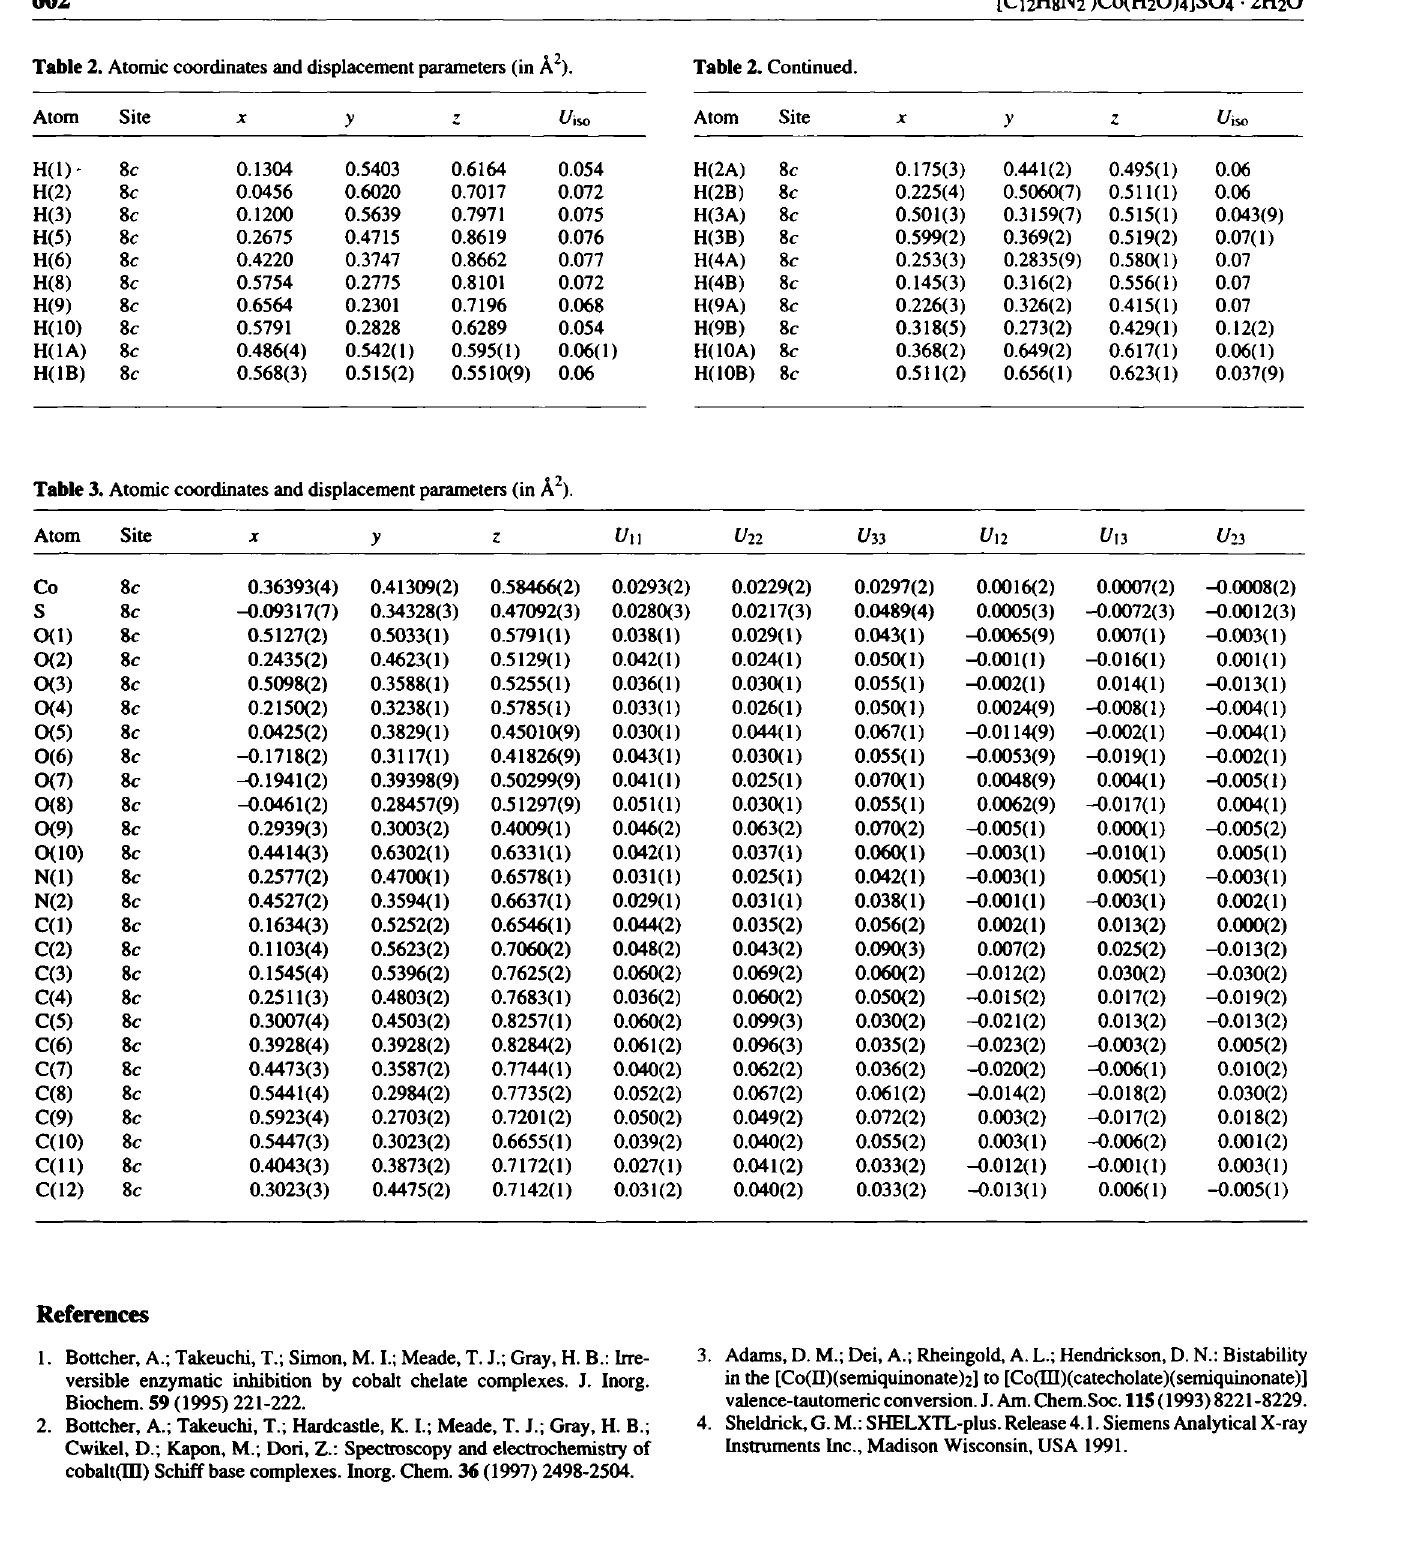
Table 2. Atomic coordinates and displacement parameters (in Â 2 ).